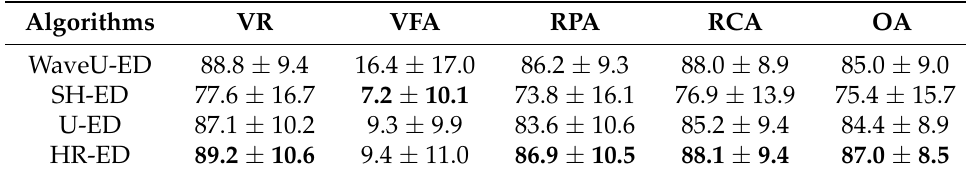
Table 1. Comparison of different singing voice separation methods for vocal melody extraction (VME) on ADC2004 dataset.